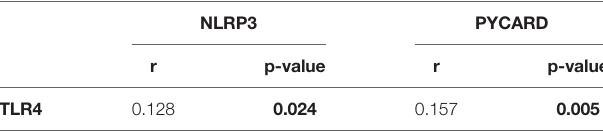
TABLE 3 | Spearman for rank-based correlations between protein expression in breast cancer patients on continuous variables. NLRP3